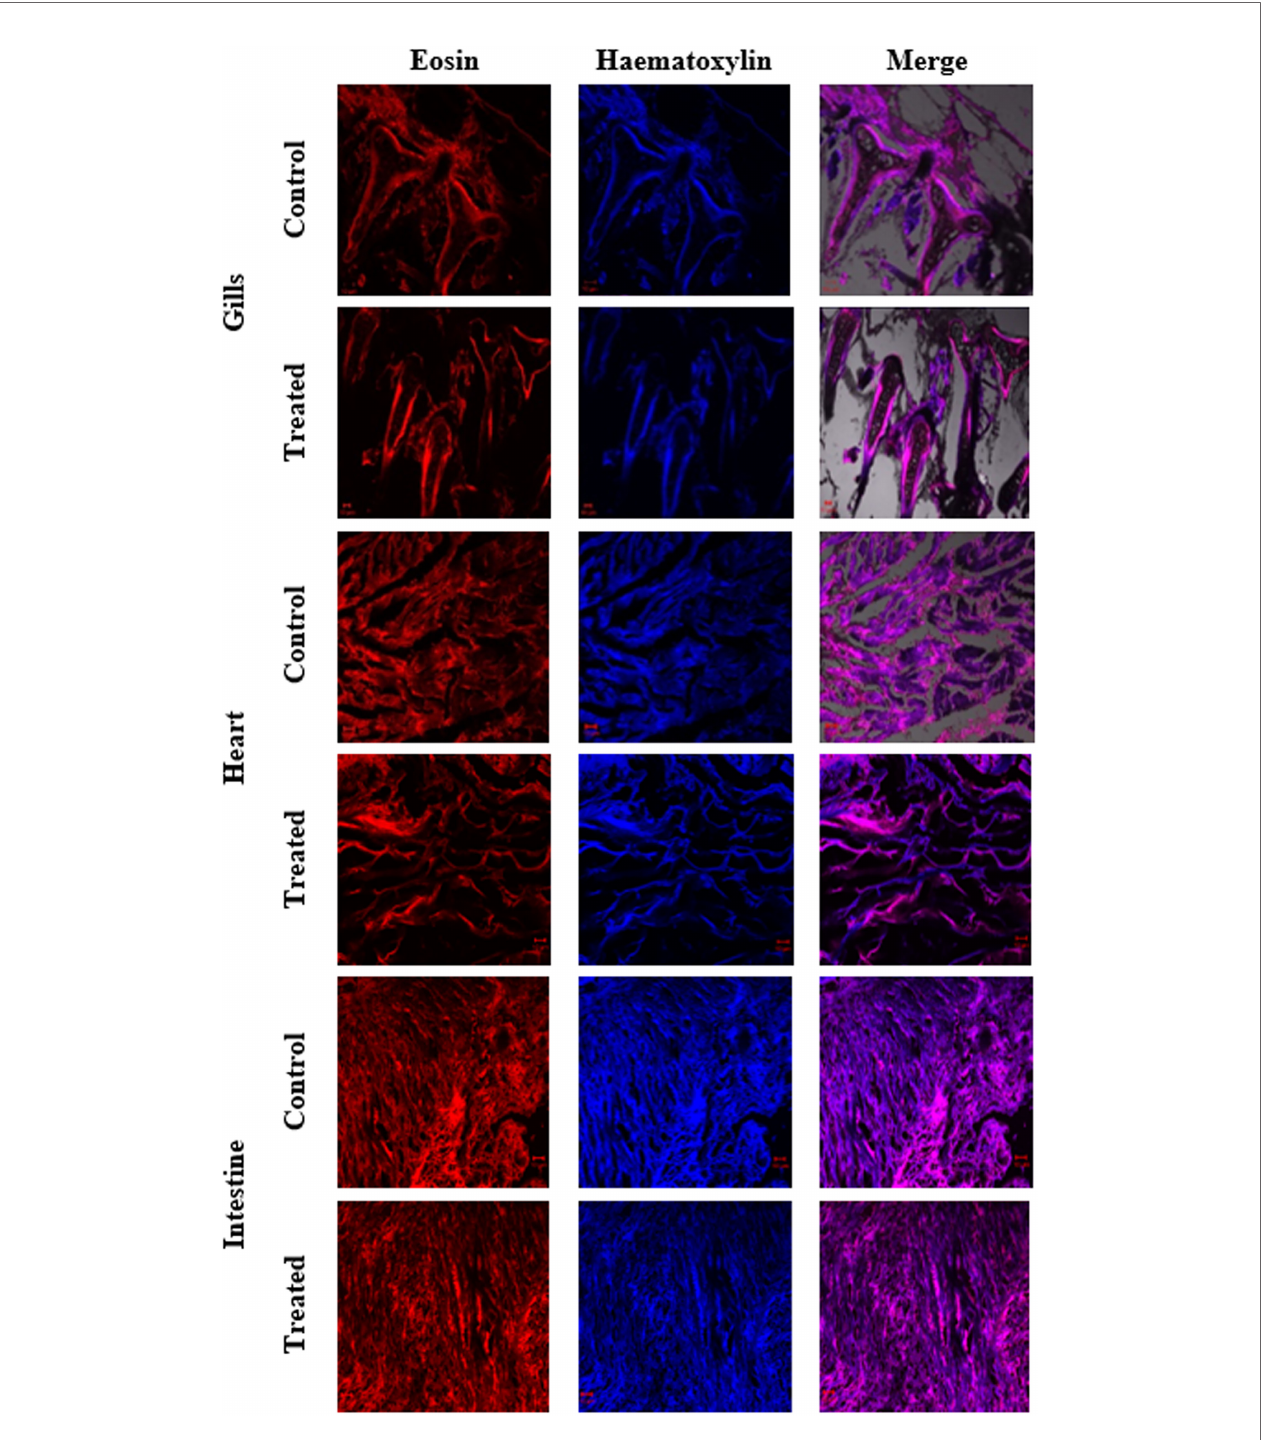
FIGURE 9 | Histological changes in major organs (gills, heart, and intestine) of control and treated zebra fi sh D. rerio were evaluated after the 21-day exposure of NHP (500 µg/L).